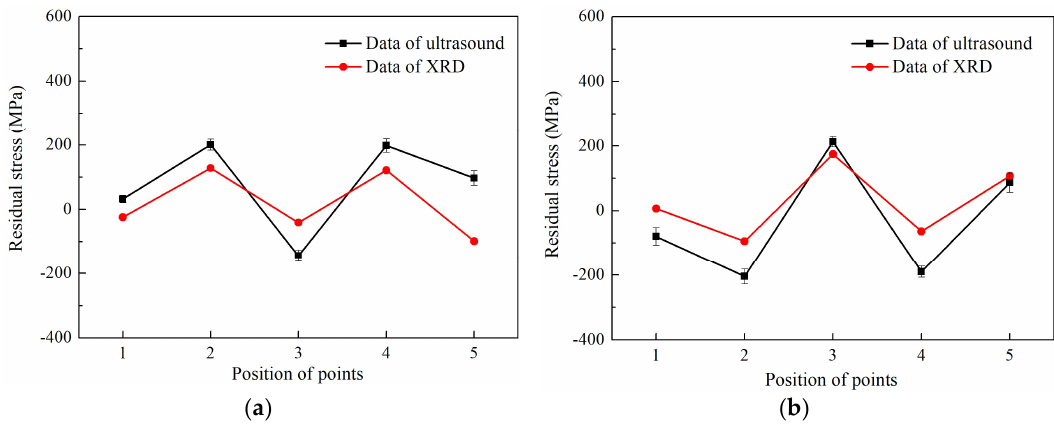
Figure 7. Comparison of stress results measured by ultrasound and XRD in Specimen 1#: ( a ) x -axial direction; and ( b ) y -axial direction.